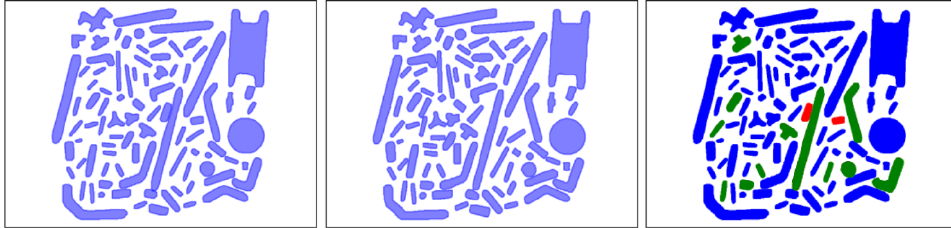
Figure 8. ( left ) Ground truth annotations for an image. ( center ) Detections from the trained network. ( right ) Correctly detected and classified bricks in blue (76 bricks), not detected bricks in red (2 bricks, 2.2%) and misclassified in green (12 bricks, 13.3%). The obtained application-oriented metric score is